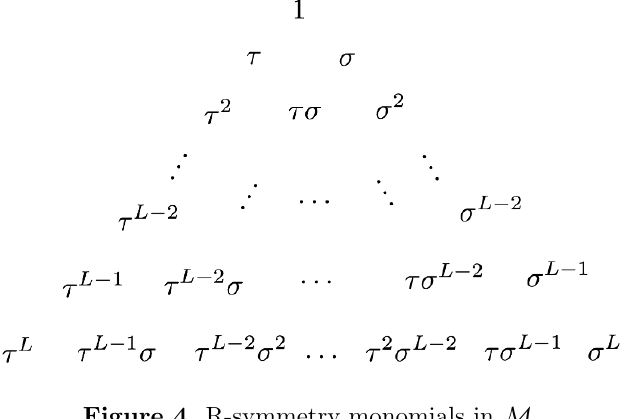
Figure 4 . R-symmetry monomials in M .